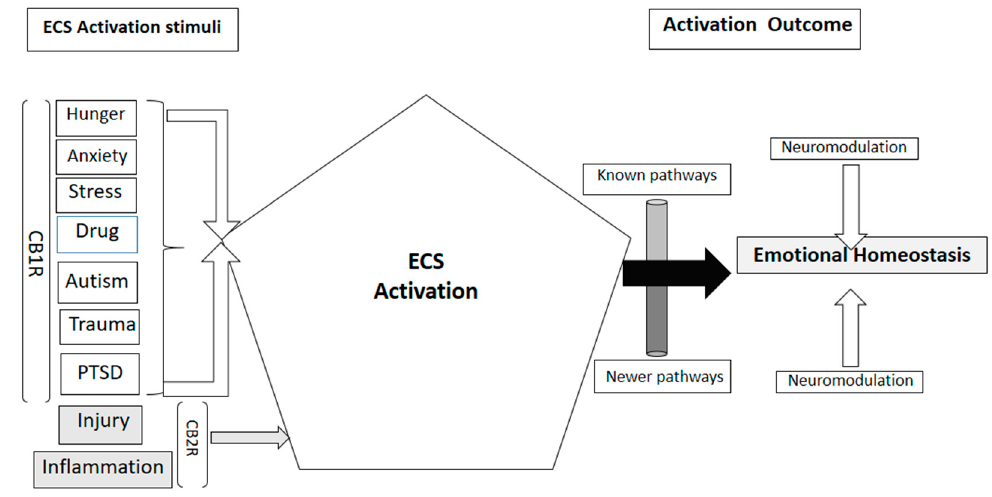
Figure 1. Schematic representation of stimuli that can activate the endocannabinoid system (ECS) and their impact through endocannabinoid receptors CB1R and CB2R, some pathways of neuromodulation are known, newer research studies are constantly revealing newer pathways .